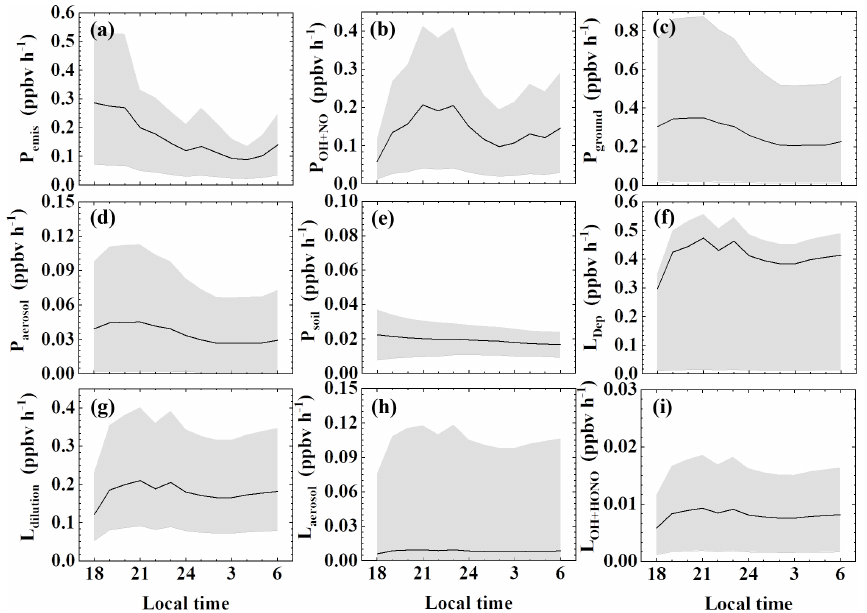
Figure 5. Nocturnal variations of the terms in the HONO budget: (a) primary emission from vehicle exhaust, (b) homogeneous reaction of NO + OH, (c) heterogeneous conversion of NO 2 on ground surfaces, (d) heterogeneous conversion of NO 2 on aerosol surfaces, (e) soil emission, and HONO losses from (f) dry deposition, (g) dilution, (h) uptake on aerosols, and (i) HONO + OH during 27 September– 9 November 2018 in Guangzhou. In each plot, the black line is the HONO production rate with the median parameter value, and the gray shadow represents their lower and upper